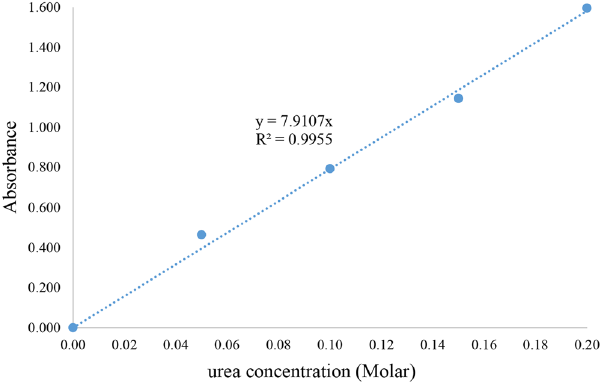
Figure 2. The linear calibration curve of urea standard